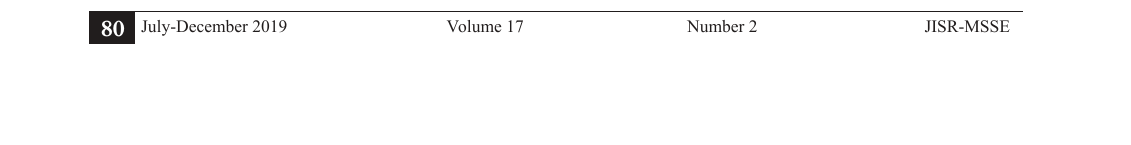
Figure 6. The output surface of FIS for the 2nd